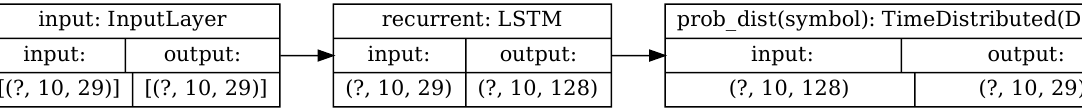
Figure 10. Sketch of the architecture of the language model of Hadoop Distributed File System (HDFS) logs.